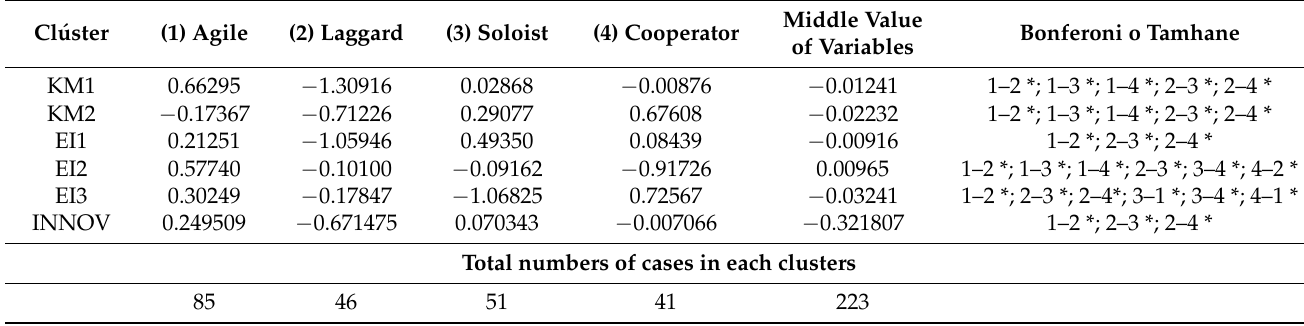
Table 5. Centre of final clusters and average values of the